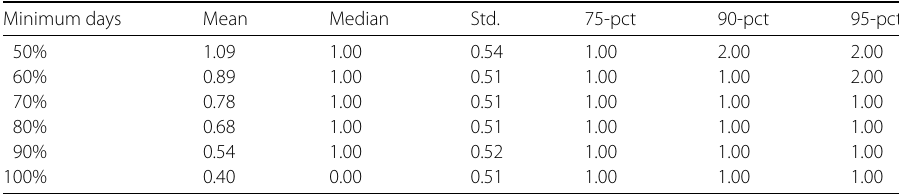
Table 2 Descriptive statistics of the favorite locations